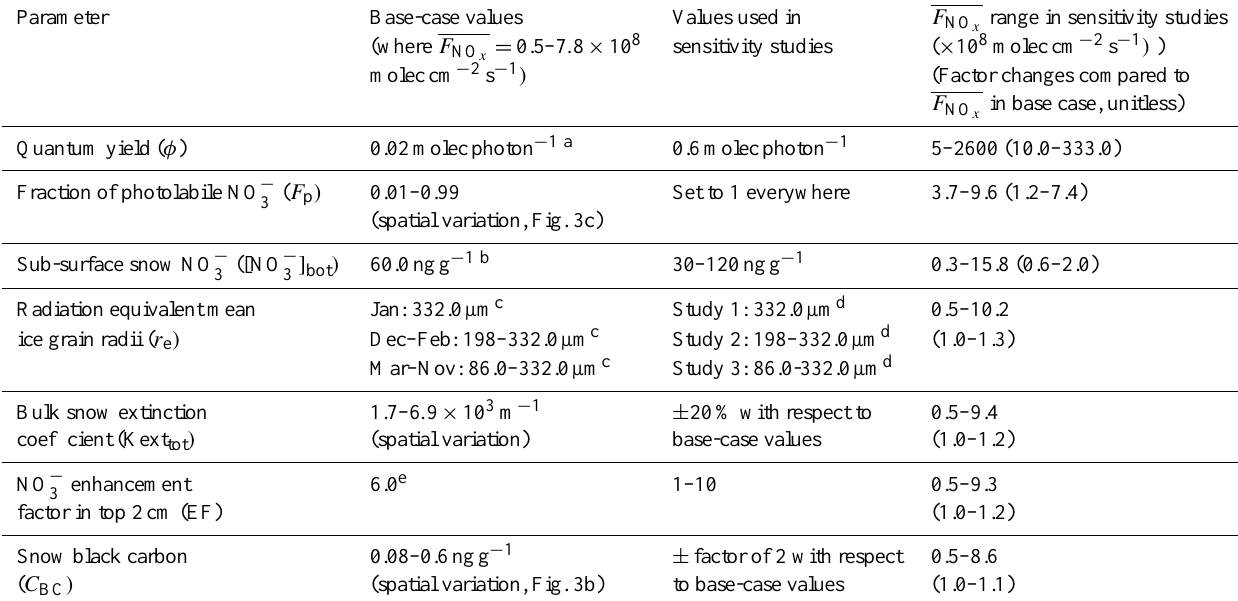
Table 3. Dependence of mean austral summer (DJF) flux of snow-sourced NO x ( F NO of photolabile NO − ( F p ) , snow NO − concentrations below 2cm ([NO − 3 3 extinction coefficient (Kext tot ) , the NO − concentration enhancement factor in the top 2cm (EF), and snow black carbon 3